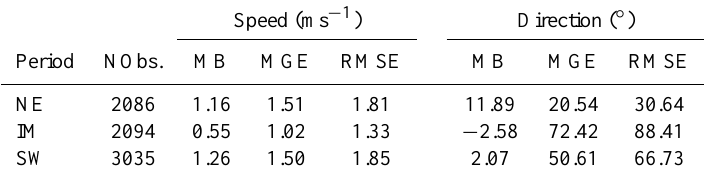
Table 6. Same as Table 4 but for wind speed and